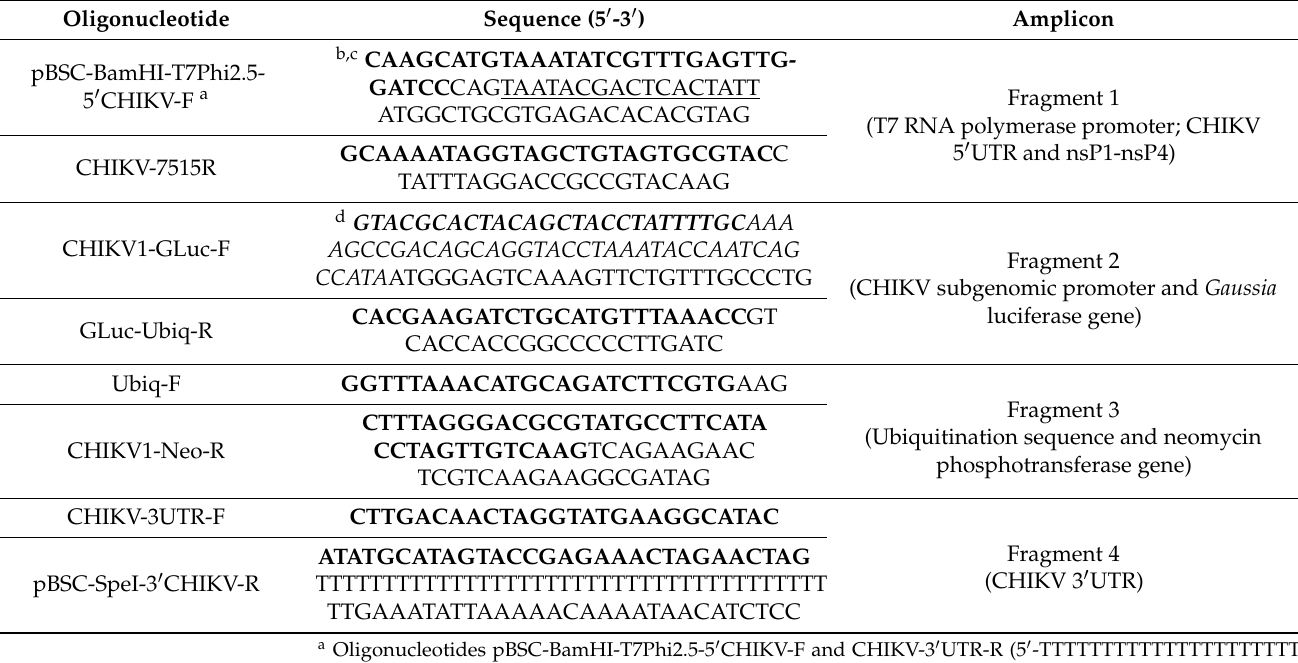
Table 1. Oligonucleotides used to construct